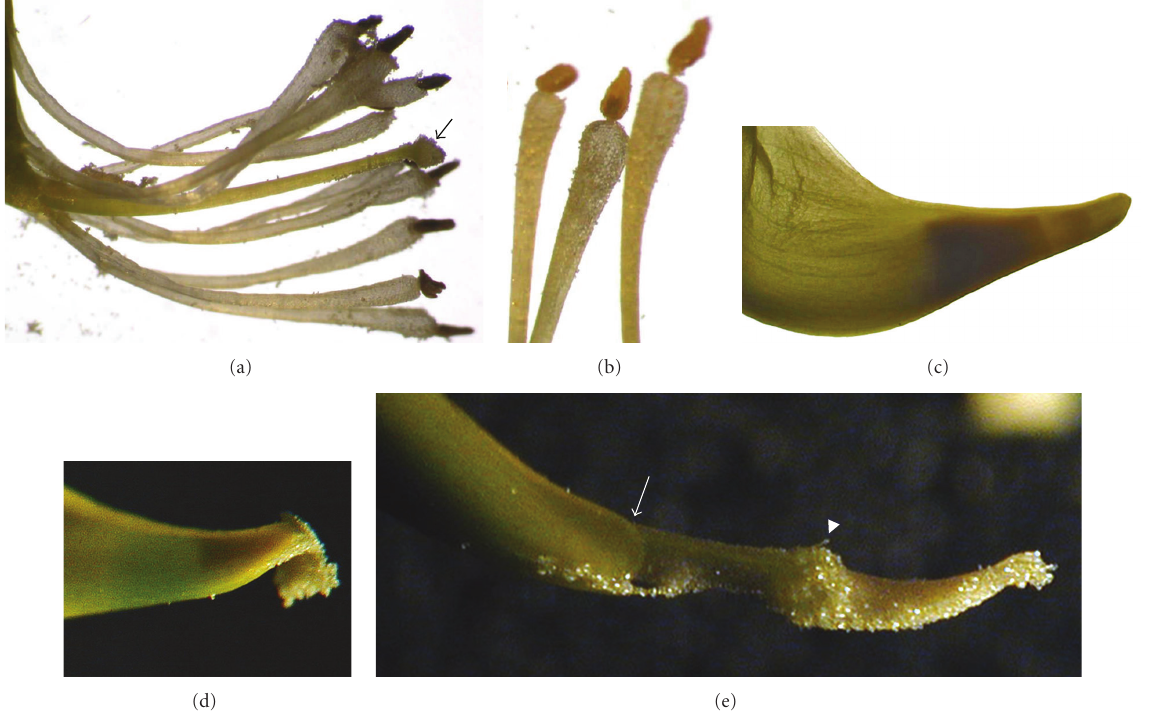
Figure 5: (a) The bunch of style and filaments of C. emerus ; the arrow points out the capitate stigma. (b) Clavate and flat apex of filaments with the erect anthers. (c) The style and free parts of the filaments clamped into the keel tip. (d) Pollen squeezed from the keel tip. (e) Pollen, stigma (arrowhead), and upper part of the style protruding from the keel petals (arrow).